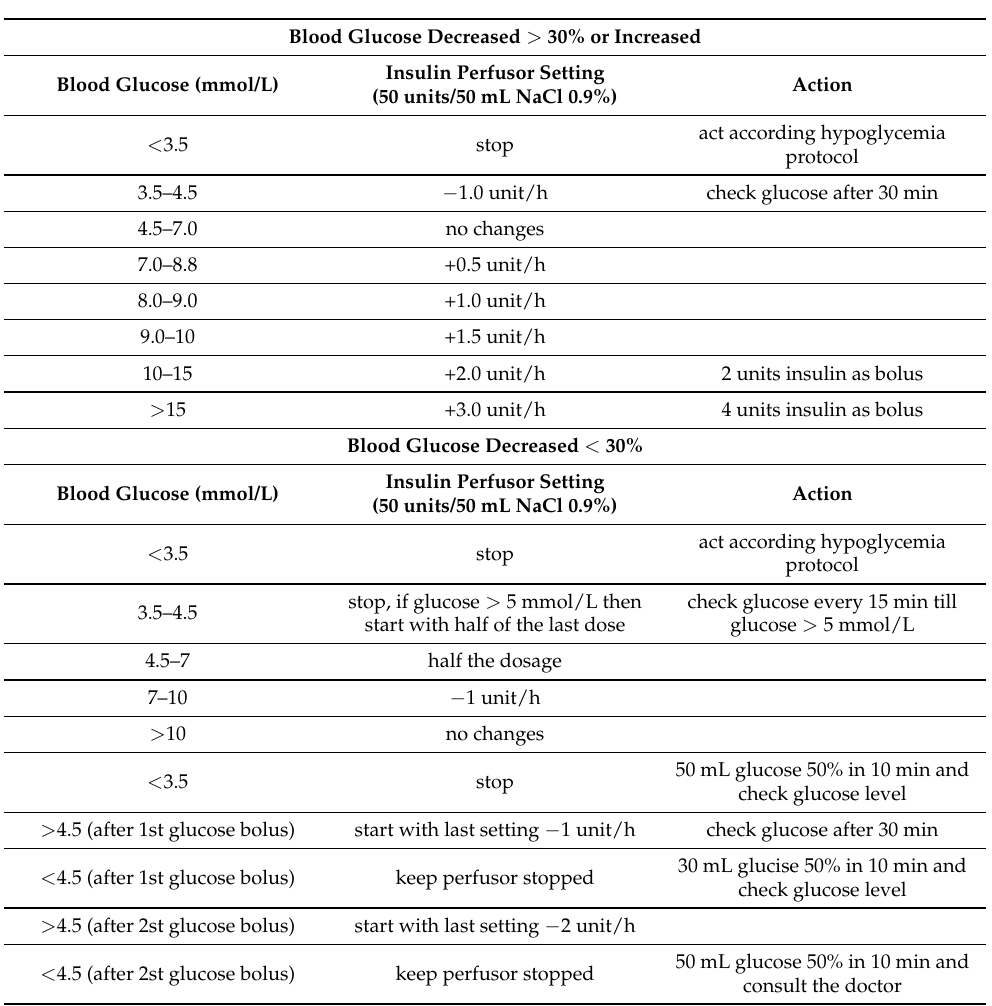
Table 2. Perfusor adaptation scheme for glucose management protocol used in the